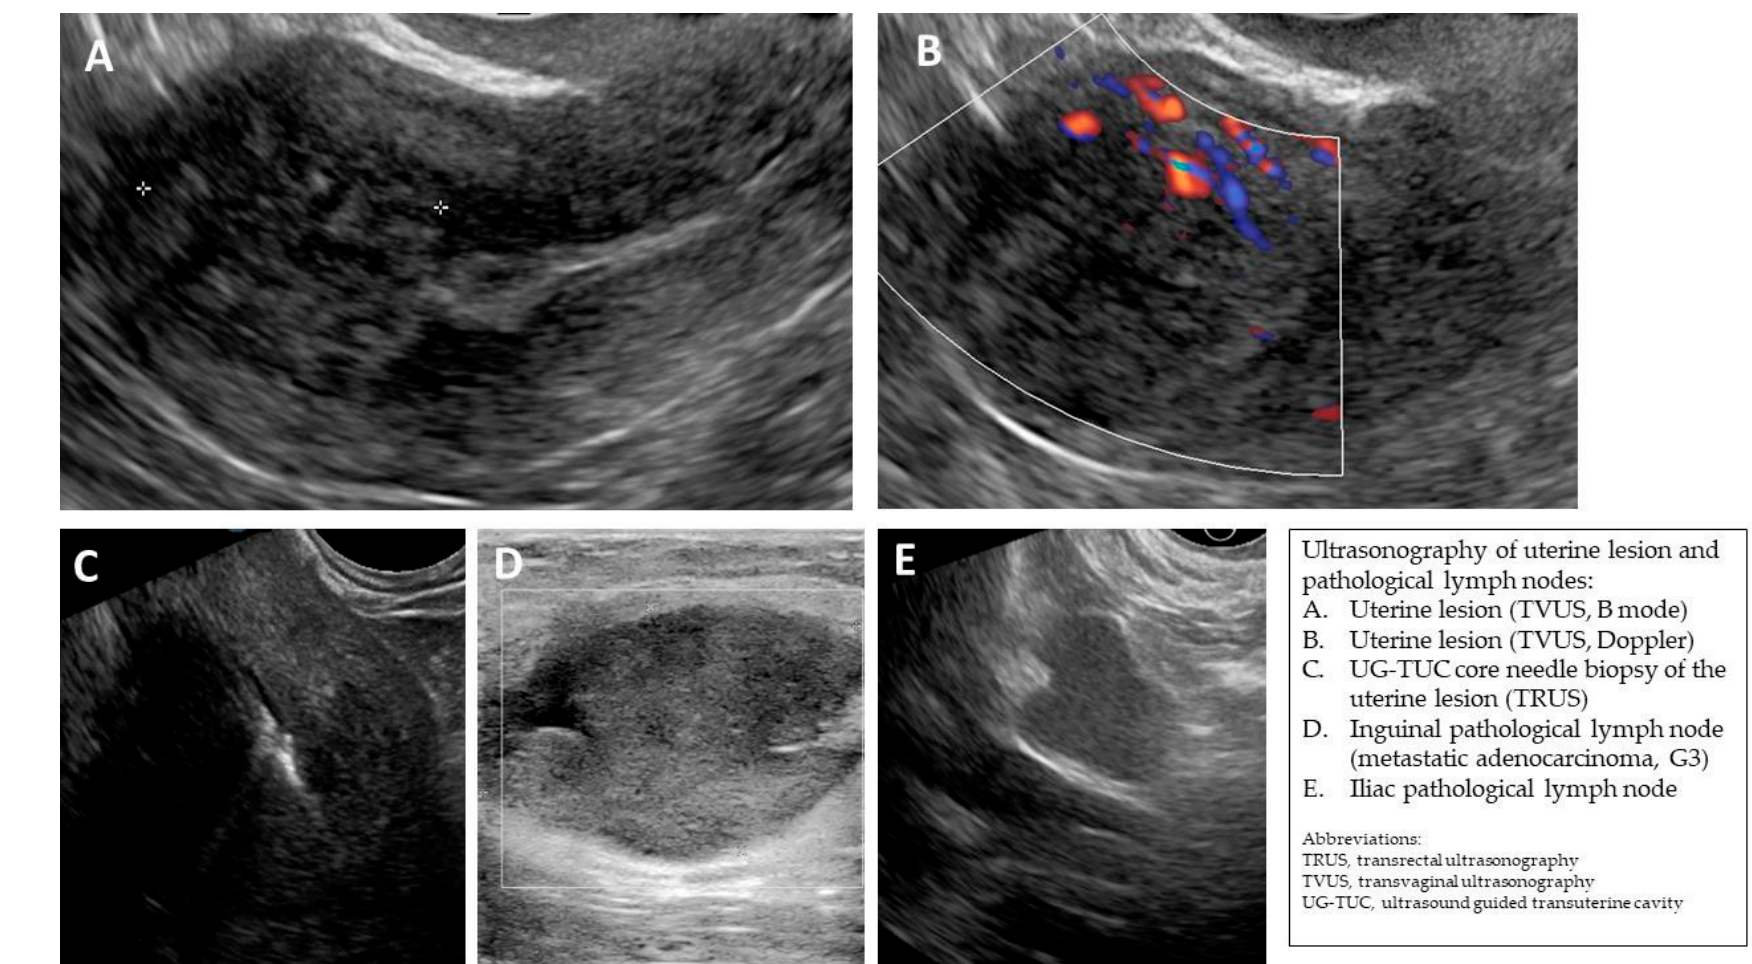
Figure A5. ( A,B ) Transvaginal ultrasonogram of the uterine lesion (atypical) in the myometrium in the uterine doom, B mode and Doppler. ( C ) Transrectal ultrasonogram of the UG-TUC core needle biopsy of the myometrial lesion. ( D ) Ultrasonogram (linear probe) of the pathological inguinal lymph node. ( E ) Transvaginal ultrasonogram of the pathological iliac lymph node. Histology: leiomyoma (uterine lesion), normal endometrium (from curettage), adenocarcinoma G3 in the inguinal lymph node (biopsy).